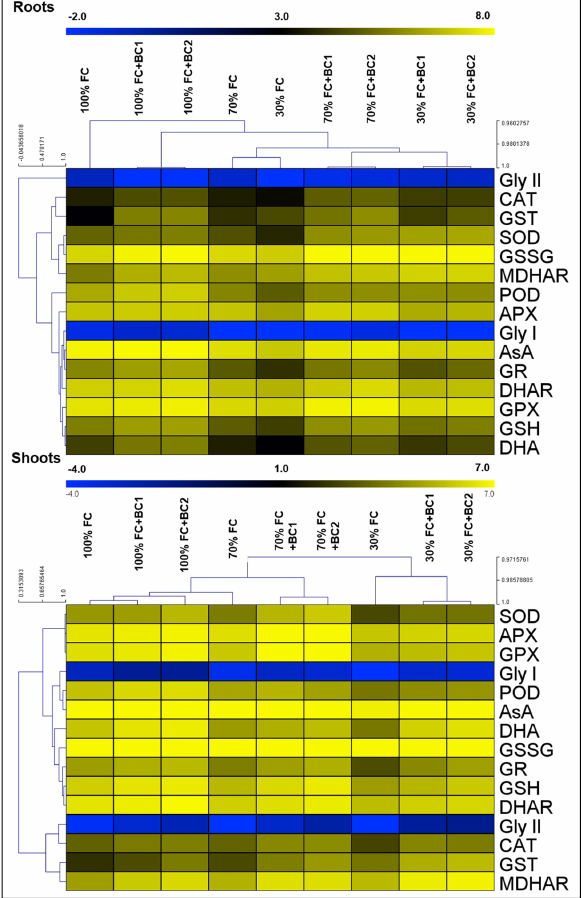
Figure 4. Biochar-dependent modifications in the antioxidant activities of drought-stressed L. fusca plants. Field capacity (FC), biochar (BC), superoxide dismutase (SOD), ascorbate peroxidase (APX), glutathione peroxidase (GPX), glyoxalase I (Gly I), peroxidase (POD), ascorbic acid (AsA), dehy- droascorbate (DHA), glutathione disulfide (GSSG), glutathione reductase (GR), glutathione (GSH), dehydroascorbate reductase (DHAR), glyoxalase II (Gly II), catalase (CAT), glutathione-S-transferase (GST), and monodehydroascorbate reductase (MDHAR), respectively. The heatmaps were developed by Multiviewer Experiment software by using log-2